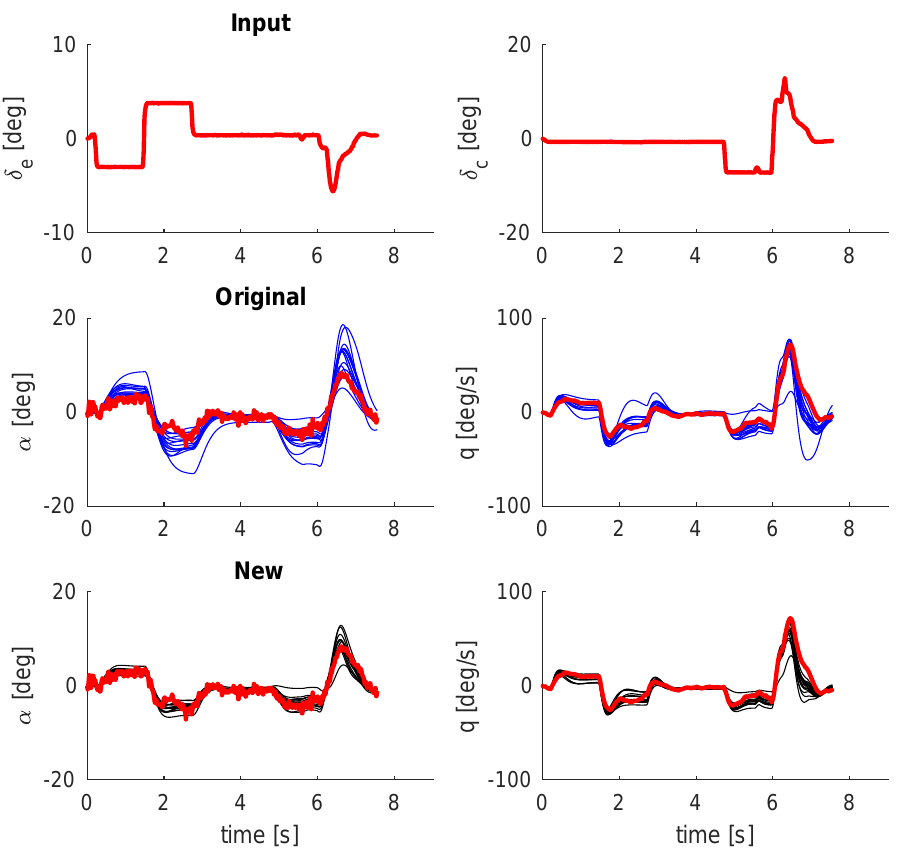
Figure 18. Validation simulations with flight test data in red. Upper: input, middle: output original method and bottom: output new method.